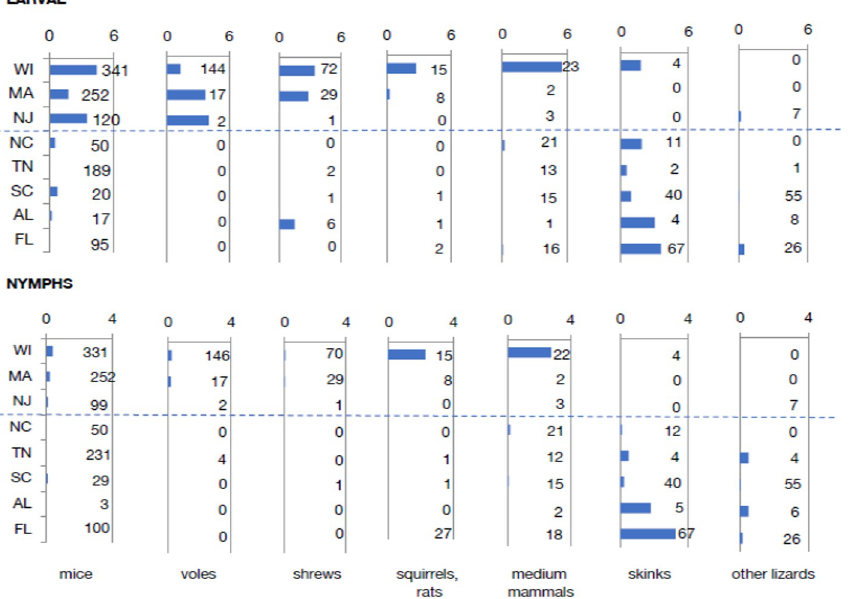
Fig 5. Latitudinal trends in tick numbers on hosts. Mean number of ticks per individual animal in each category over the season. Numbers to the right of bars indicate the number of individual captured animals from which each mean was calculated. Dashed line divides northern from southern sites. Data are available in S8 Data.